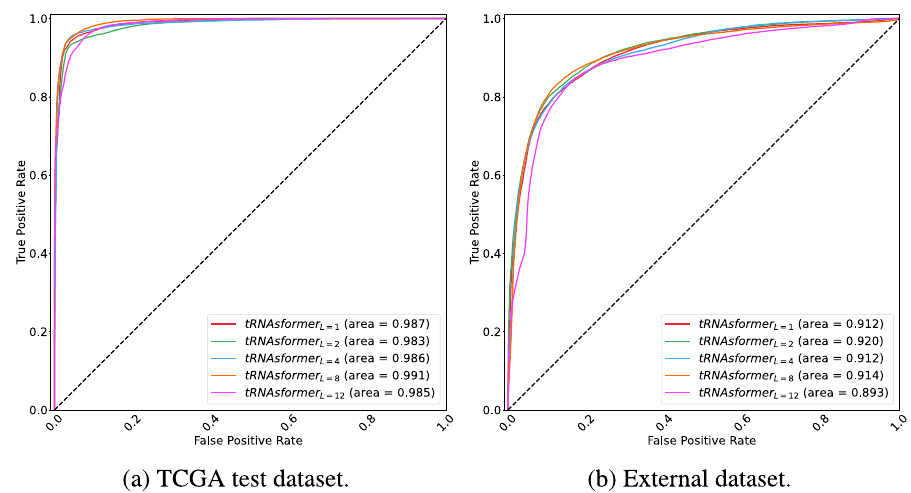
Fig. 3 ROC Curves for TCGA and External Dataset. The micro ROC curve of different models applied on a the TCGA test set and b the external dataset. The AUC is reported in the legend for all models.